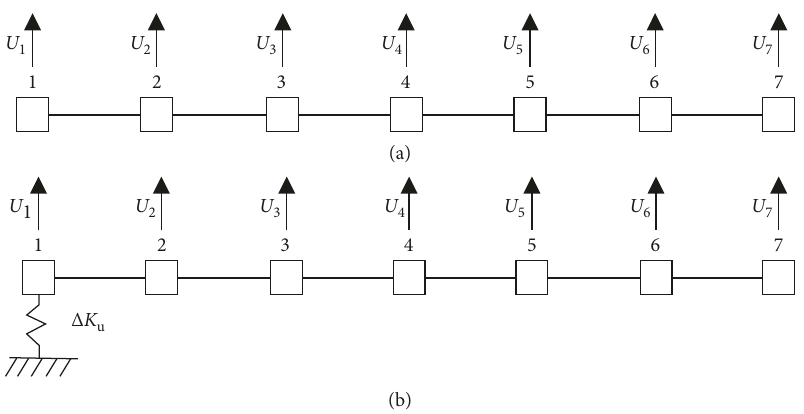
Figure 4: Analytical model of the (a) free-free and (b) pinned-free configurations.